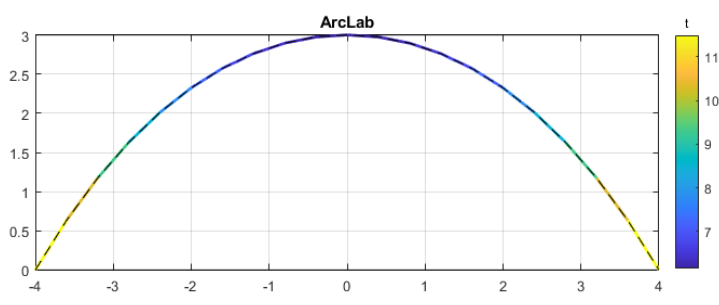
Figure 10: Optimal shape of an arch under its own self-weight and comparison with a catenary curve (dashed)